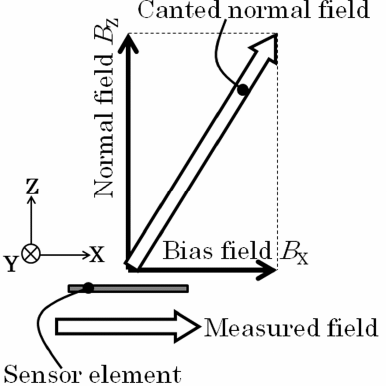
Figure 4. Schematic of magnetic field when the sensor is operated.